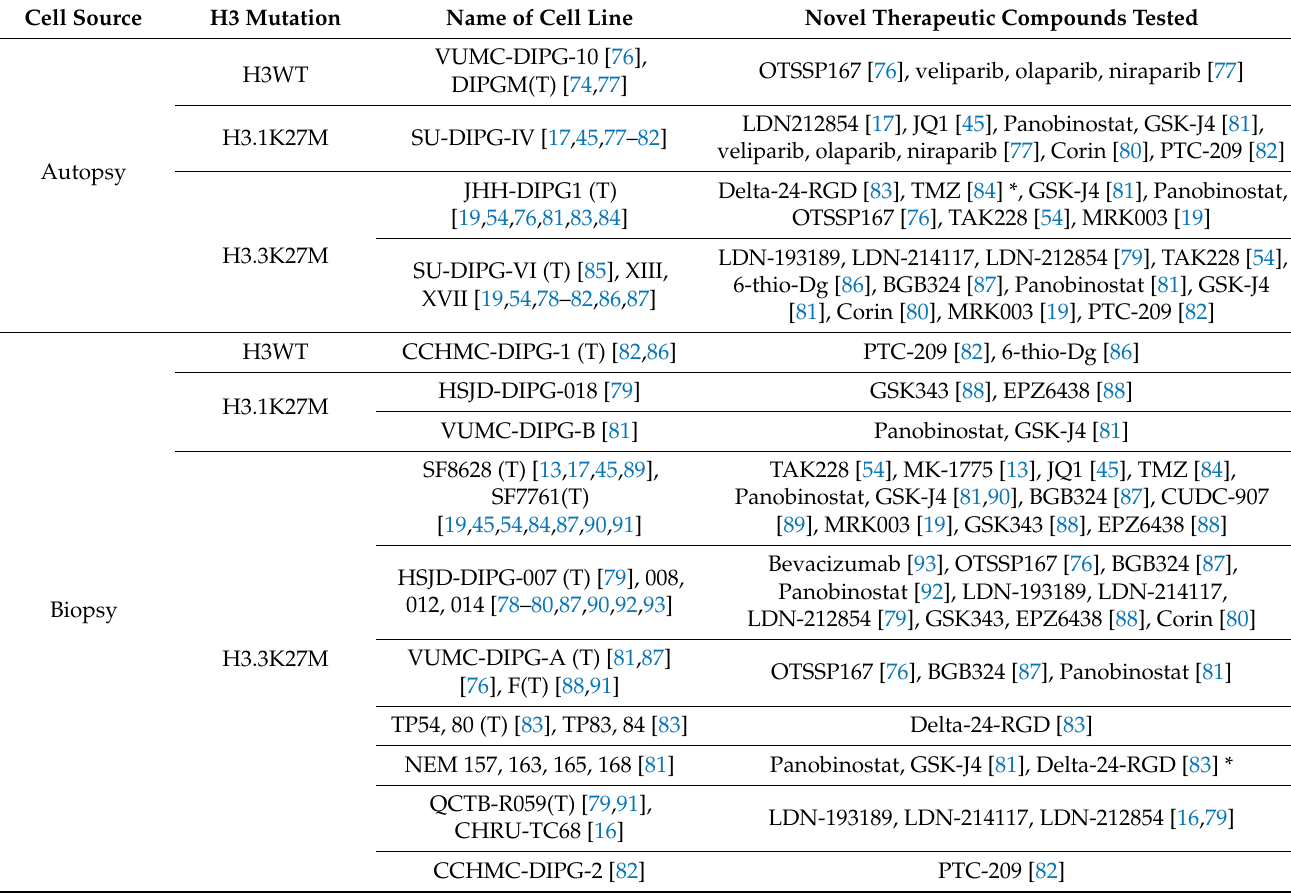
Table 1. Patient derived DIPG cell lines for in vitro culture and for in vivo generation of orthotopic mouse models. Cell Source H3